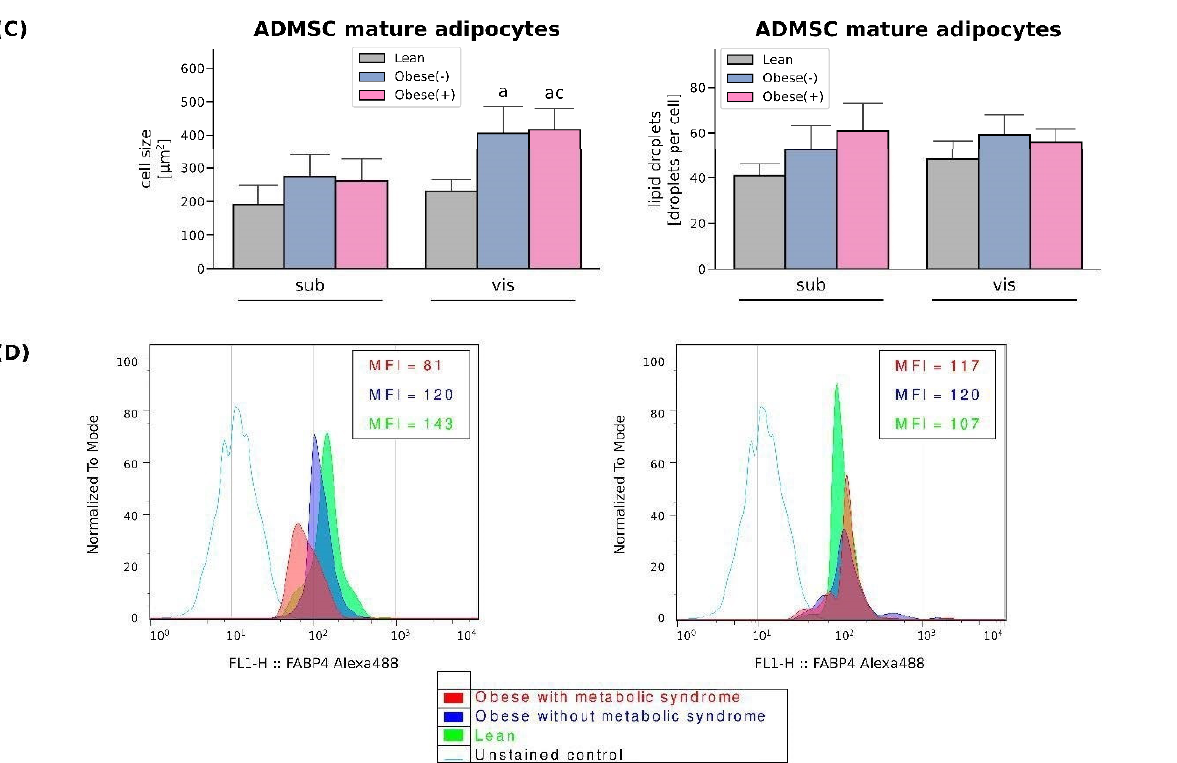
Figure 1. Viability of cultured ADMSCs and their differentiation into adipocytes. ( A ) Viability of ADMSCs derived from both subcutaneous and visceral adipose tissues. ( B ) Quantification of neutral lipids content in the undifferentiated and differentiated ADMSCs derived from lean, obese(-) and obese(+) individuals. Representative images of undifferentiated and adipogenically differentiated ADMSCs are shown. Lipid droplets inside the cytoplasm were stained with Oil Red O solution [200 × magnification]. ( C ) Quantification of the average cell size [ µ m 2 ] and the number of lipid droplets per cell. Bars and whiskers represent the mean and SD, respectively. Number of patients equals three (measurements taken in triplicate). a–difference vs. Lean group in the studied tissue; b–difference vs. Obese(-) group in the studied tissue; * significantly different from undifferentiated cells, p < 0.05. Designation of the groups: Obese(-)–obese without metabolic syndrome patients; Obese(+)–obese with metabolic syndrome patients. ( D ) Representative histograms of FABP4 expression in adipocytes differentiated form sub- and visADMSCs obtained from lean and obese